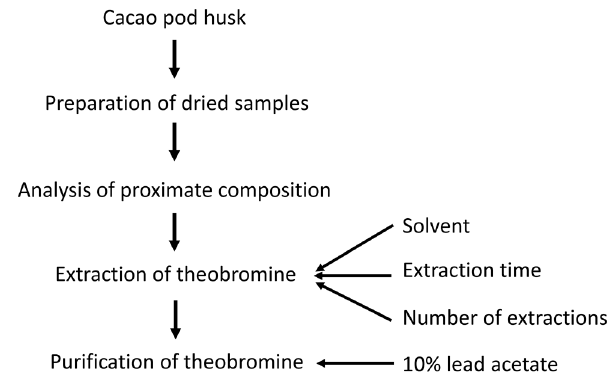
Figure 2. Overall experimental procedure of the study.